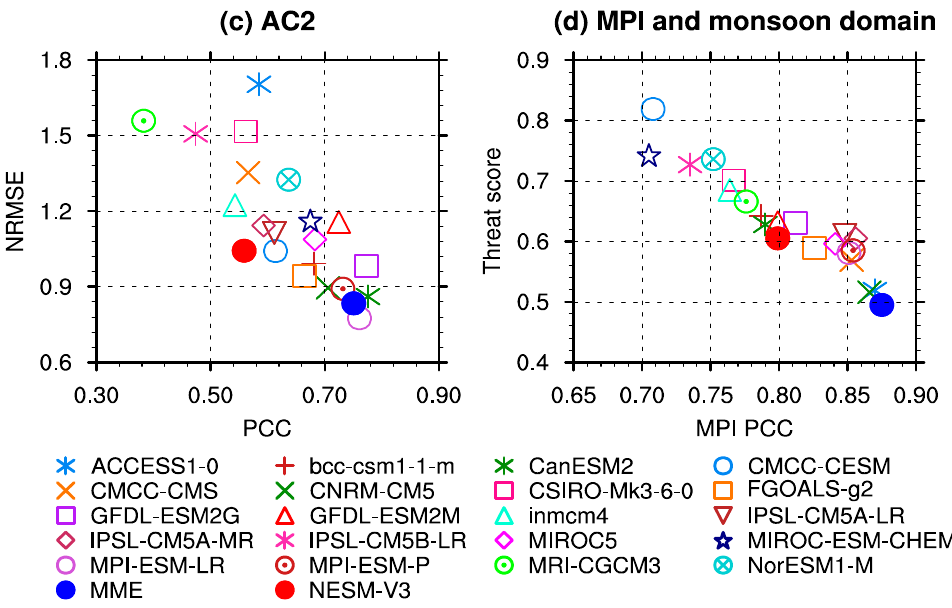
Figure 2. The models’ performance on simulation of Asian-Australian monsoon (AAM) precipitation climatology (1979–2005): ( a ) annual mean precipitation (AM), ( b ) the solstice mode (AC1), ( c ) the equinox mode (AC2) and ( d ) monsoon precipitation intensity (MPI) and monsoon domain (measured by threat score) over 40° S–50° N, 40° E–180°.